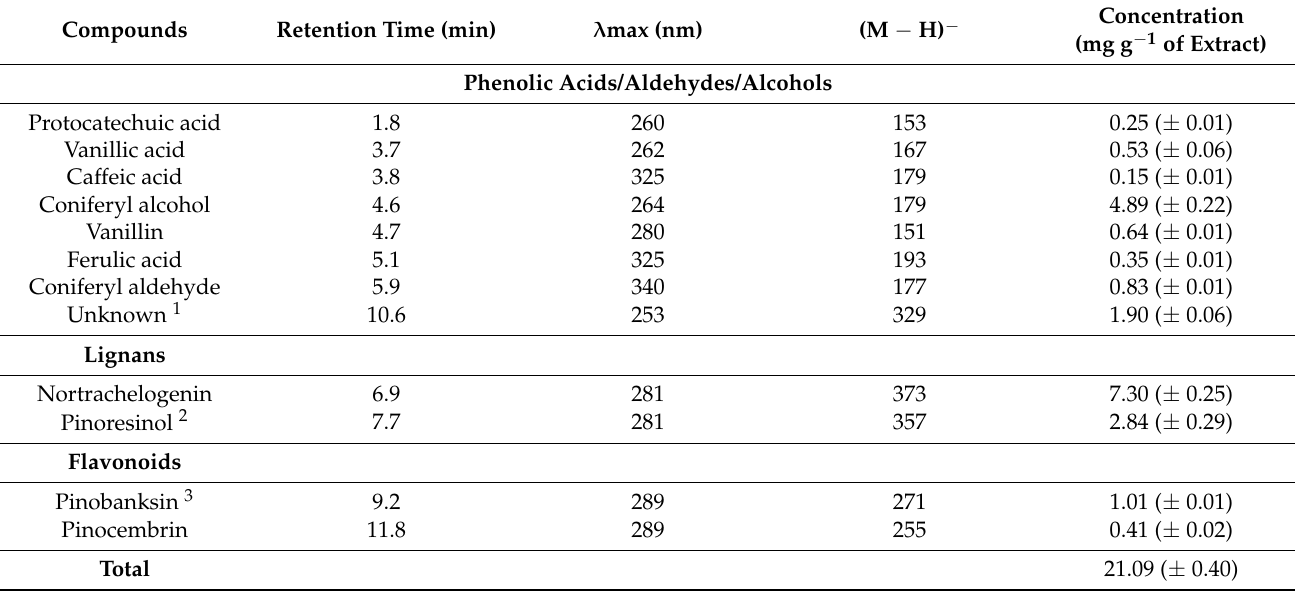
Table 2. Phenolic compounds identified in the active maritime pine sawdust extract obtained at 175 ◦